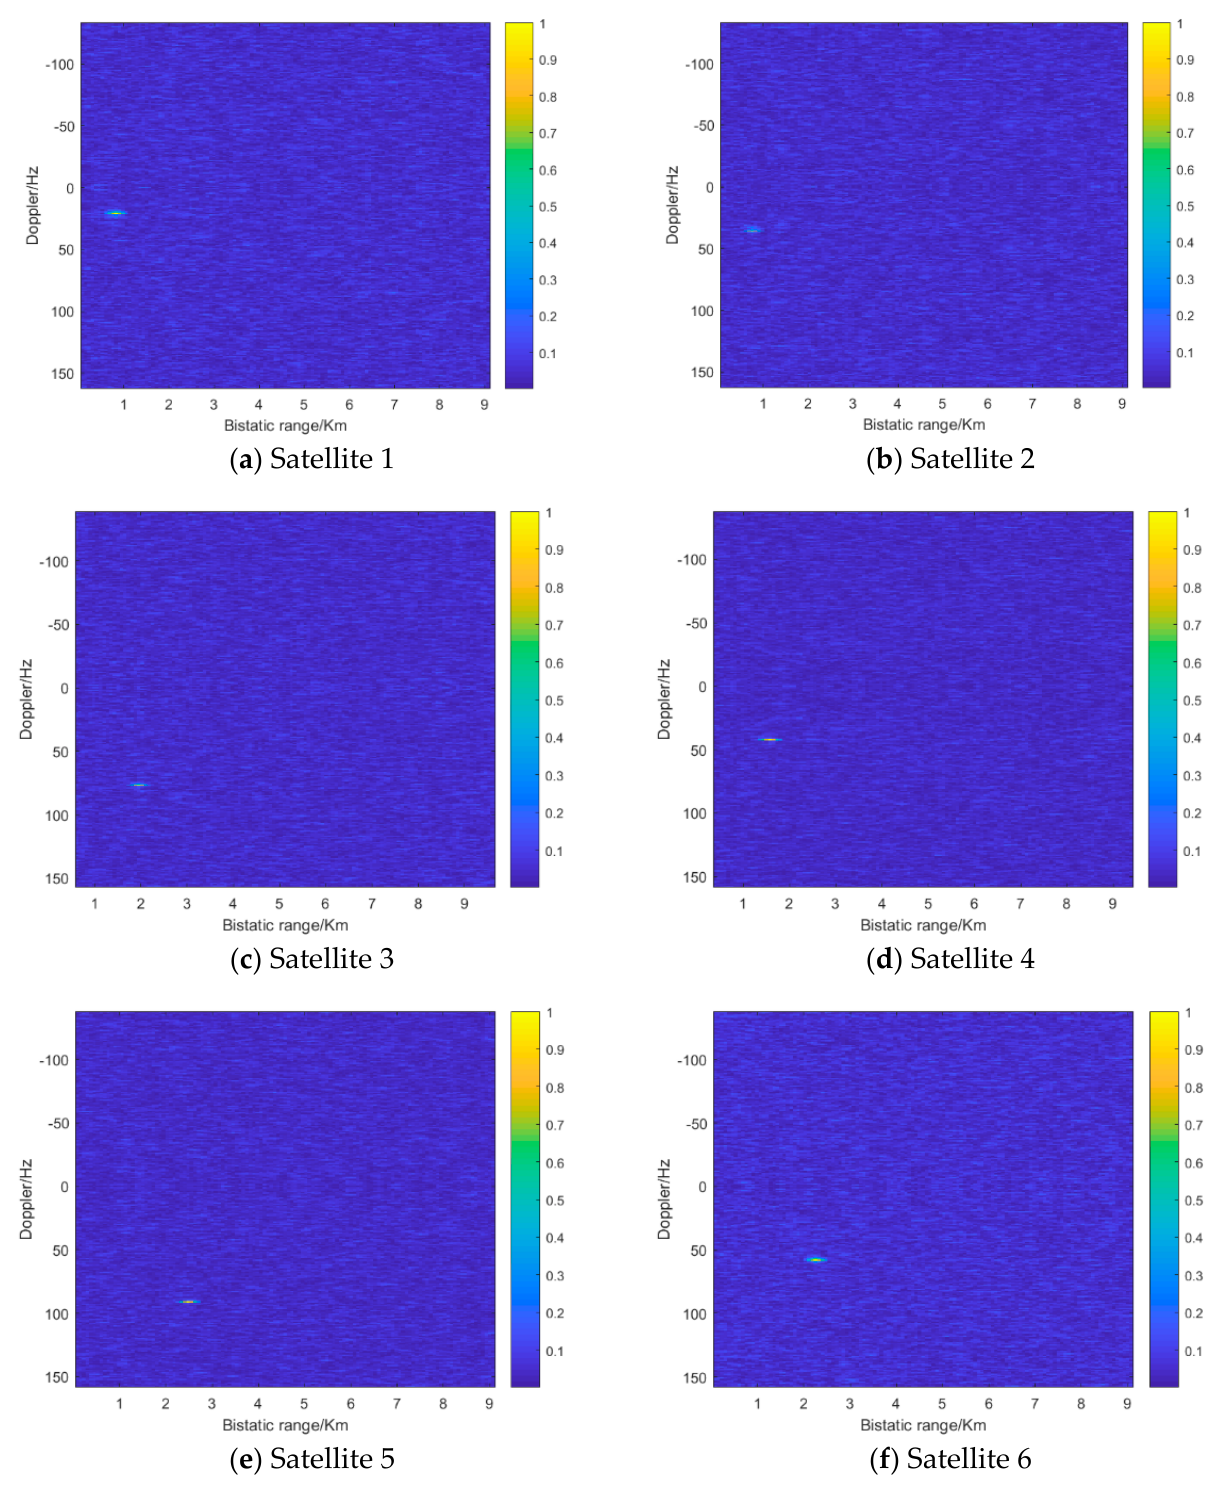
Figure 4. RD maps for different satellites.